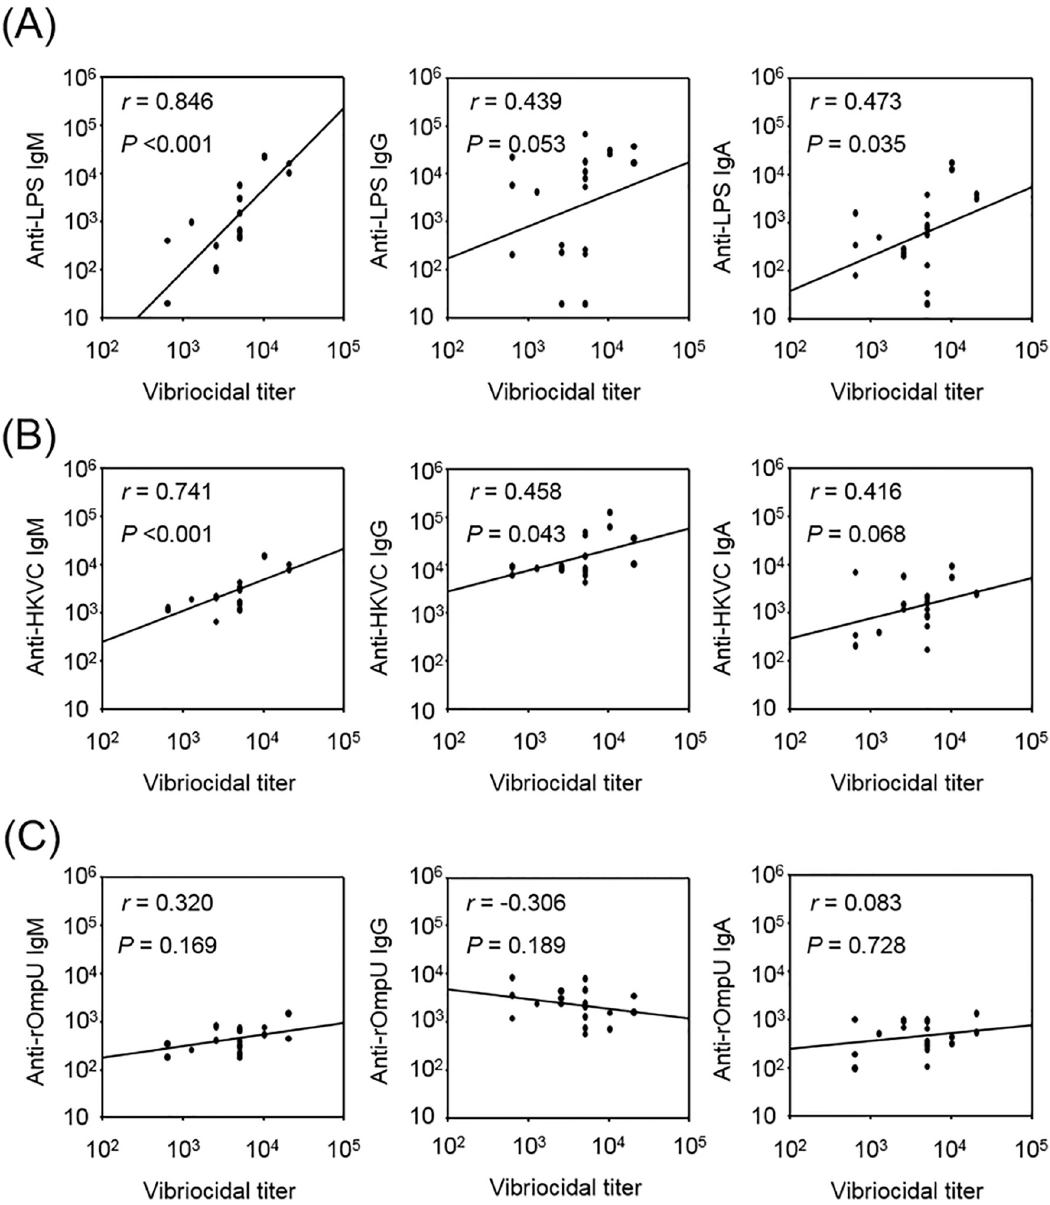
Fig 3. Vibriocidal titer was highly correlated with anti- V . cholerae LPS IgM level. The levels of serum IgM, IgG, and IgA against V . cholerae LPS (A), heat-killed V . cholerae (HKVC) (B), and V . cholerae OmpU (C) in 20 clinical serum samples were determined using ELISA and compared with their vibriocidal activities. Diagonal lines indicate regression between the two results. The Spearman correlation coefficient ( r ) and P value were obtained to compare the two